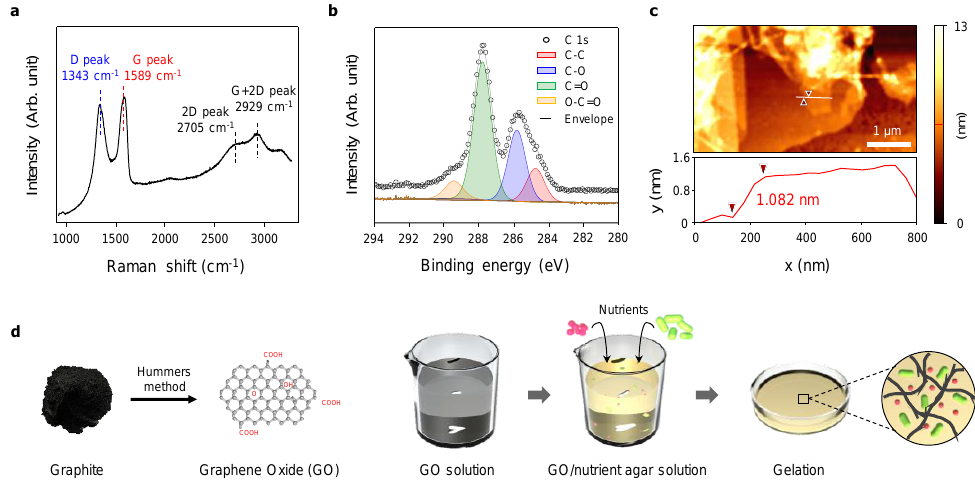
Figure 1. Fabrication and characteristics of graphene oxide (GO). ( a ) Raman spectroscopy, ( b ) X-Ray photoelectron spectroscopy, and ( c ) atomic force microscopy analyses of the fabricated GO. ( d ) Schematic of GO/Murashige and Skoog (MS) medium plate fabrication.